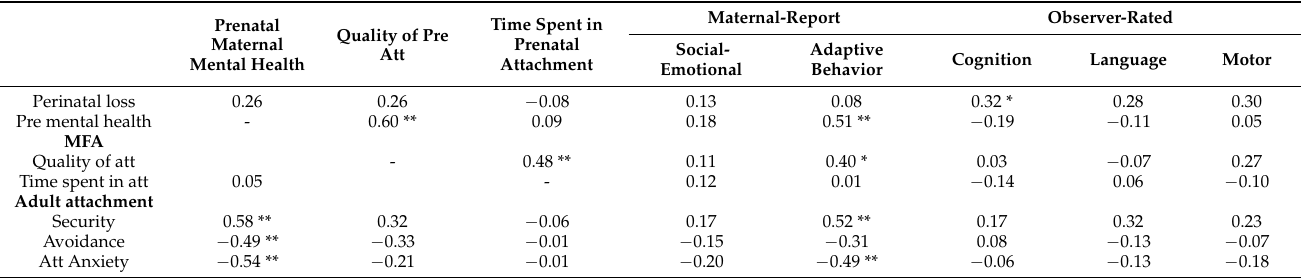
Table 3. Pearson correlation matrix of independent variables and infant developmental outcomes measured by Bayley-III, N =